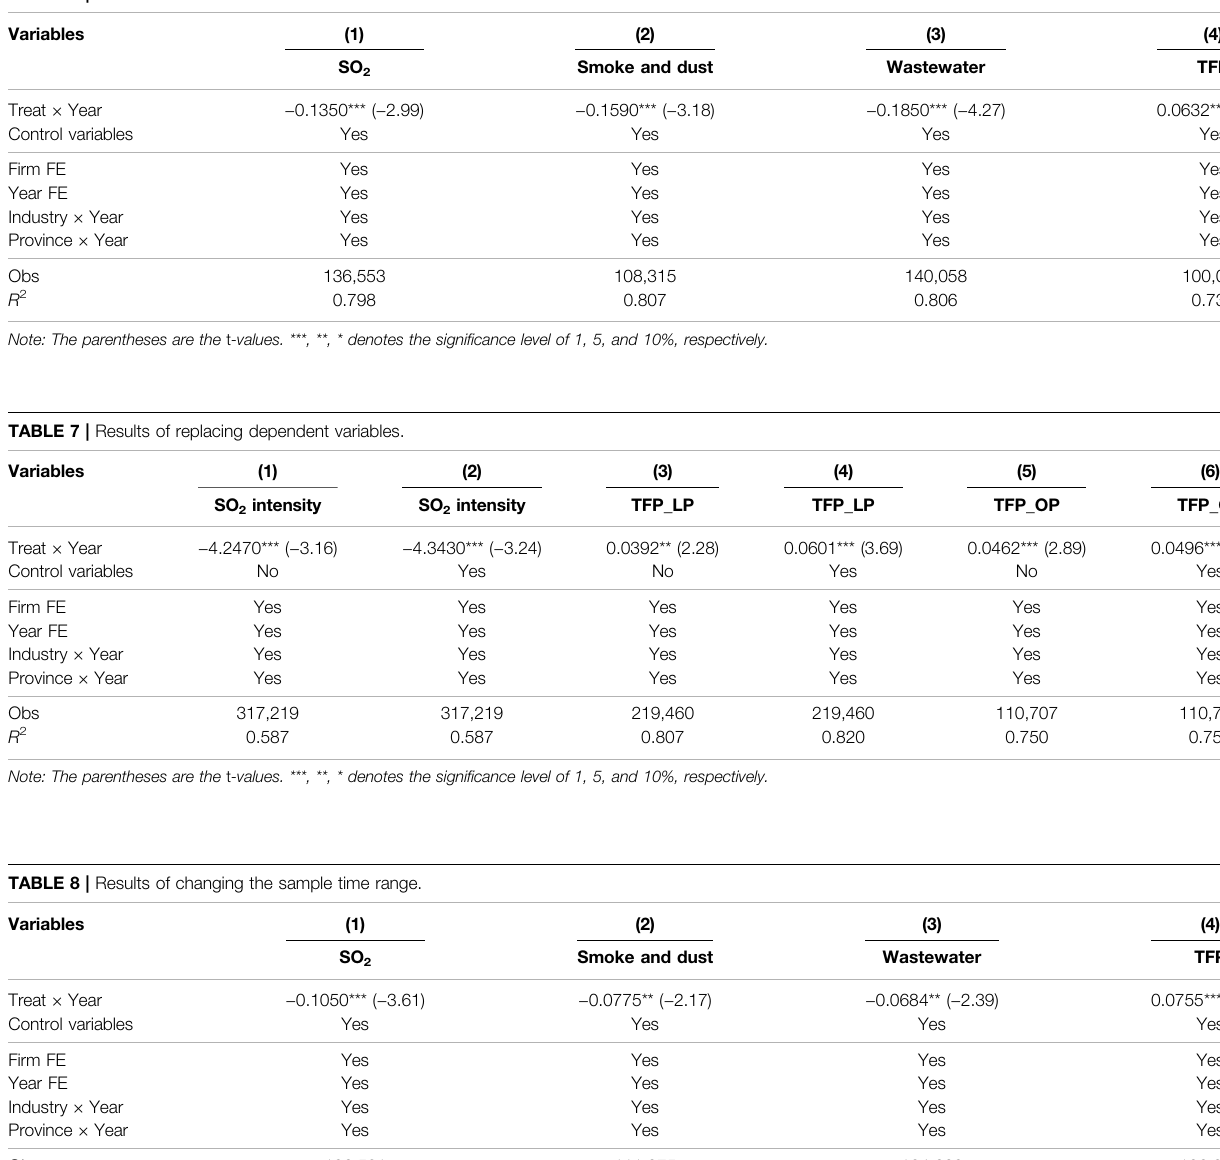
TABLE 6 | Results of PSM-DID.